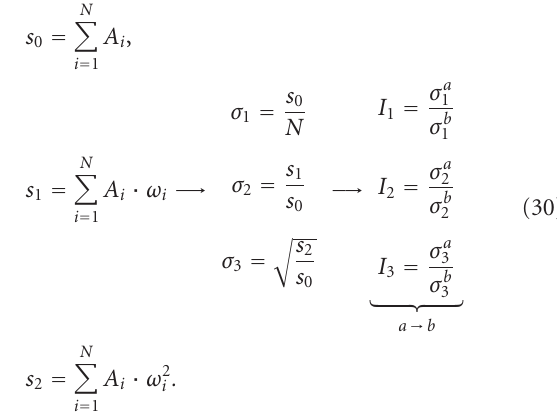
Figure 9: The aerodynamic coe ffi cients of the payload (pitching moment static stability) [10].